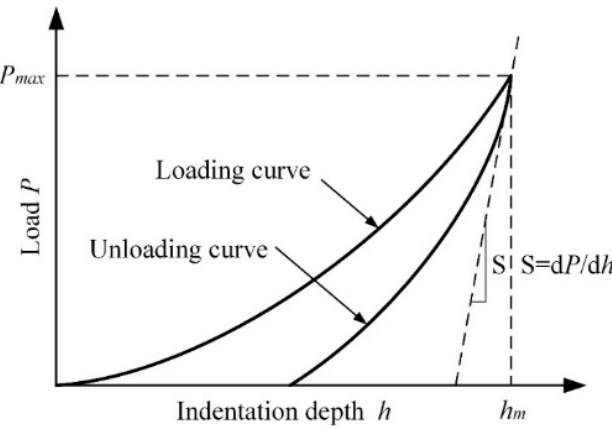
Figure 8. Loading–unloading curve of the nanoindentation test.